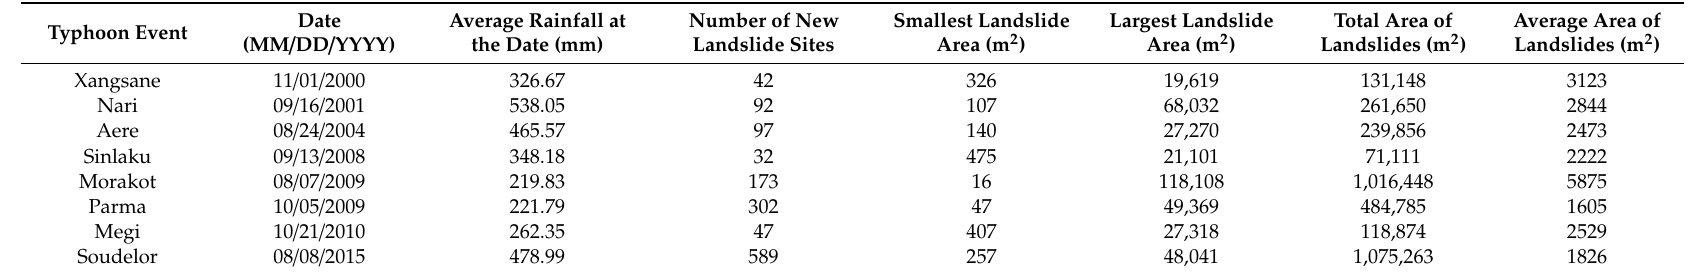
Table 1. Landslide inventory for the eight typhoon